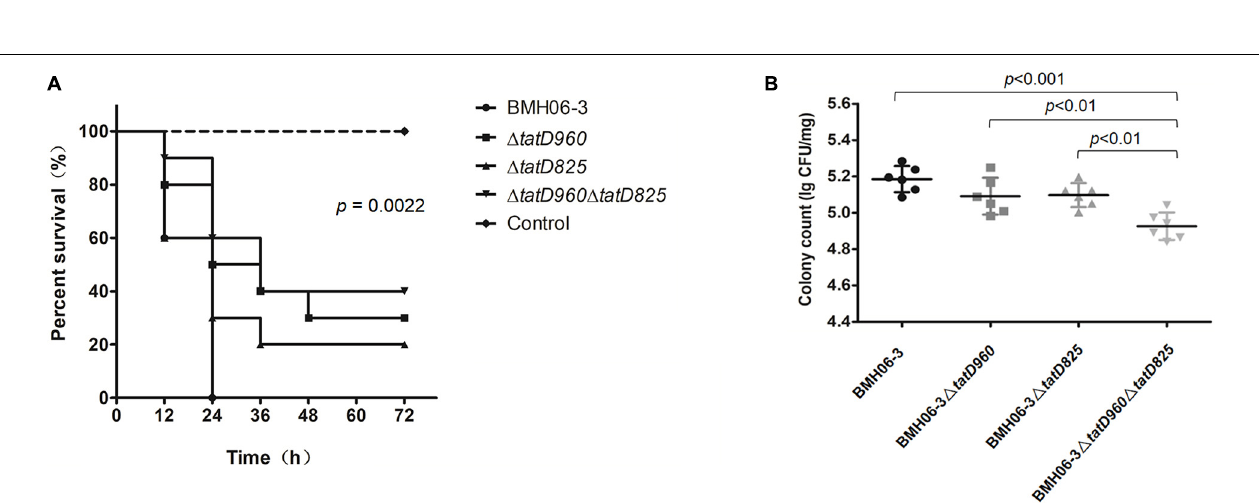
FIGURE 7 | Deficiencies in tatD genes compromise T. pyogenes virulence in mice. (A) Kaplan-Meier survival curves of mice infected intraperitoneally with the T. pyogenes wild-type strain or tatD -deficient mutants (10 mice/group). The log-rank test was used to compute the p -value in the Kaplan-Meier survival analysis. (B) Mice infected intraperitoneally with BMH06-3- or tatD -deficient mutants in BMH06-3 (6 mice/group) were assessed for T. pyogenes load in the spleen at the 24 h time point. The spleen was processed for colony counting by the dilution plating method. The bar represents mean of